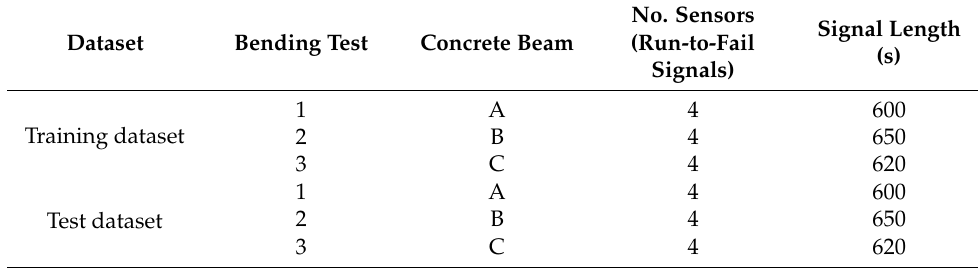
Table 1. Specifics of the experimental dataset.